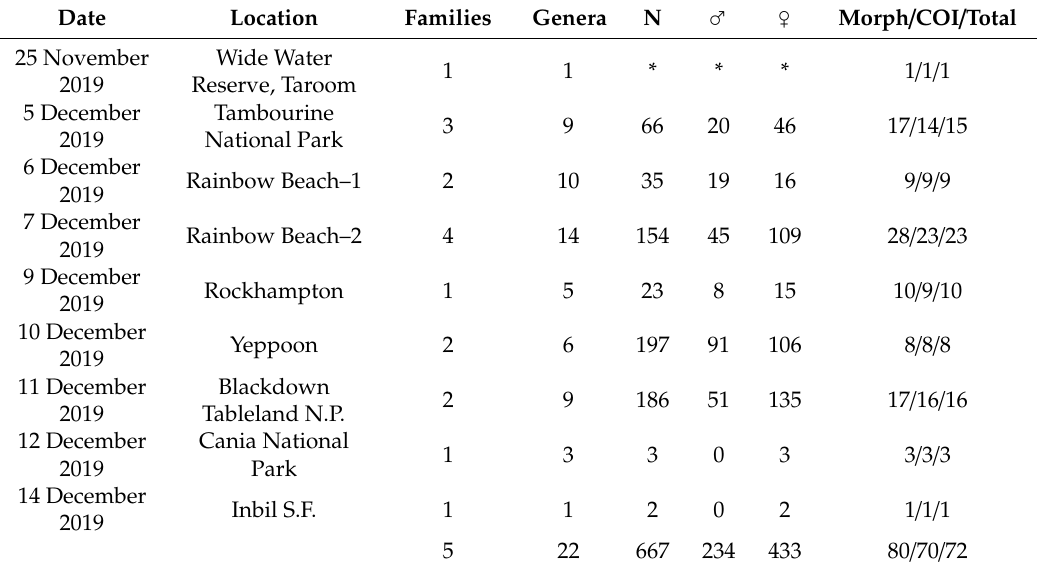
Table 1. Psyllids collected during each light trapping session. The table includes date, location, number of families, genera and individuals (N), collected divided by sex ( of species is reported based on the morphological assessment (Morph.), on the cytochrome oxidase c (COI) barcoding and on the joined total, including the 2 taxa that failed PCR amplification. The total number of families, genera and species is the overall number of di ff erent groups recorded across the eight sampling events (Table S1). Values marked with * have been estimated based on photos and not manually counted, therefore are excluded by the overall count.